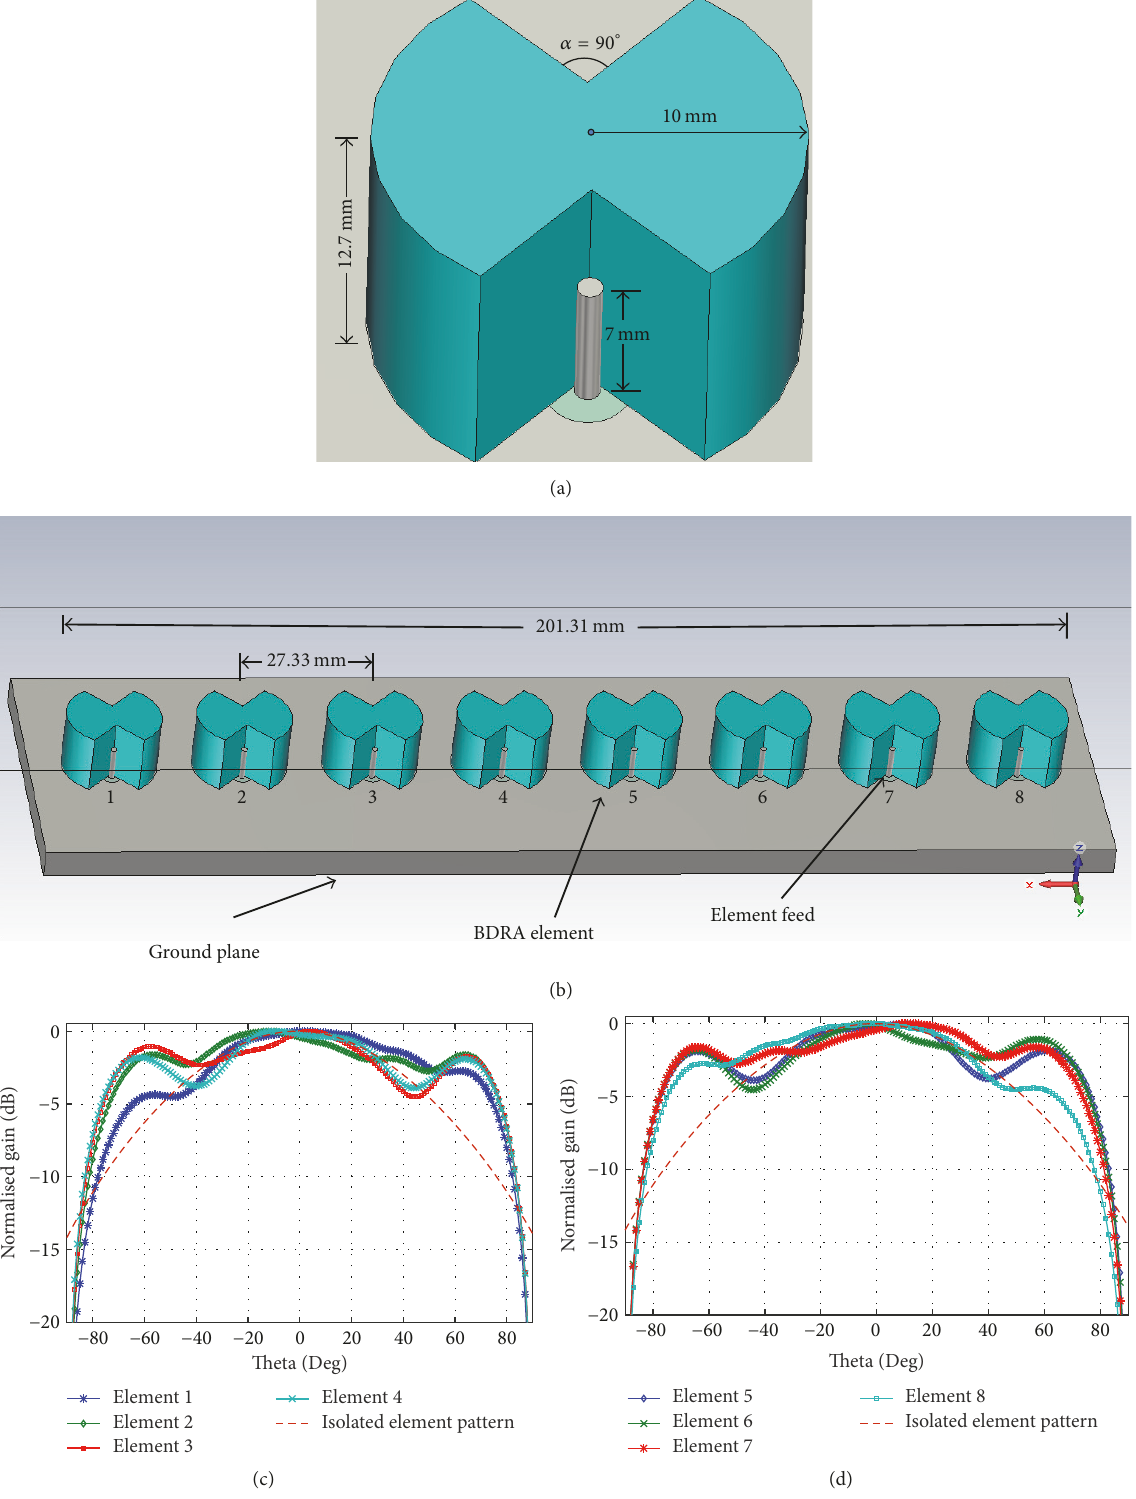
Figure 1: (a) Single BDRA element as presented in [29] given with dimensions, placed on 60 × 60 mm ground plane, (b) BDRA array designed and simulated in CST-MWS with 𝑑 = 0.41𝜆 , and (c) simulated element patterns for elements 1–4 and (d) for elements 5–8 along with the isolated element